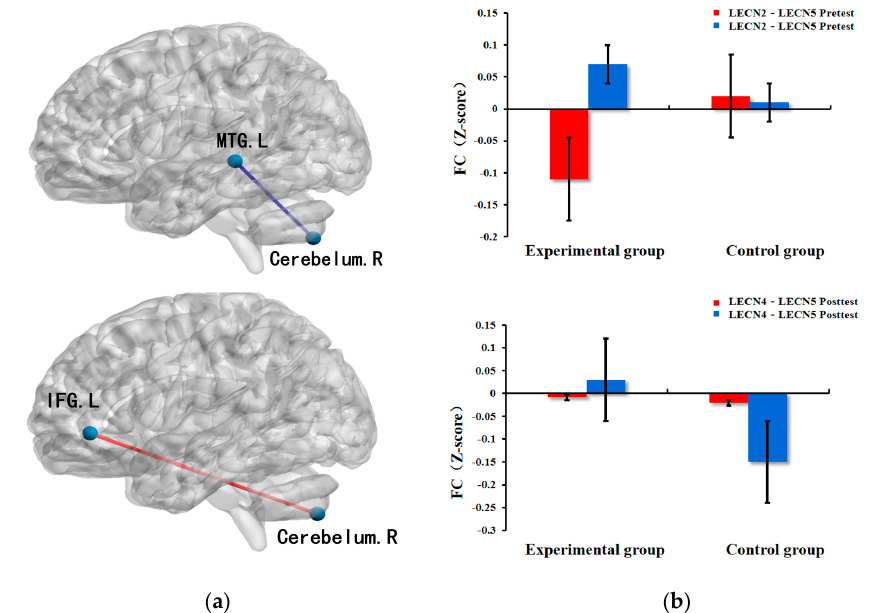
Figure 2. ECN changes caused by exercise intervention. Note: ( a ) left middle frontal gyrus, MFG.L, left middle temporal gyrus, MTG.L, right cerebellum, R, the blue nodes indicate the left ECN, the red line indicates FC enhancement, the blue line indicates FC decreased; ( b ) difference in FC values of ECN between the experimental group and the control group.